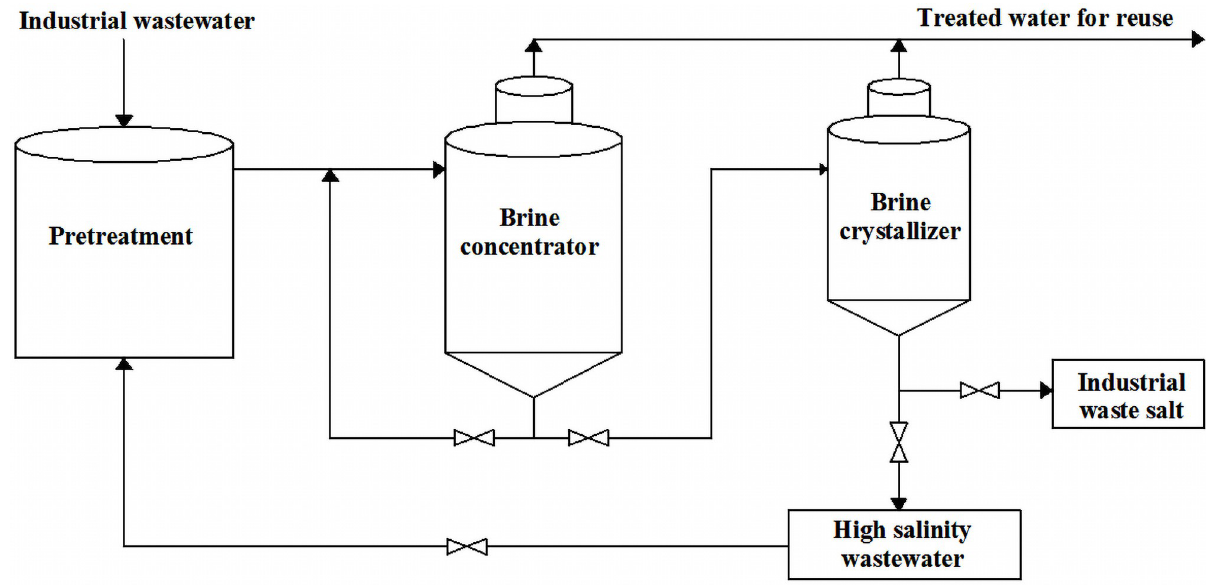
Fig 1. The evaporation crystallization process for the production of the industrial waste